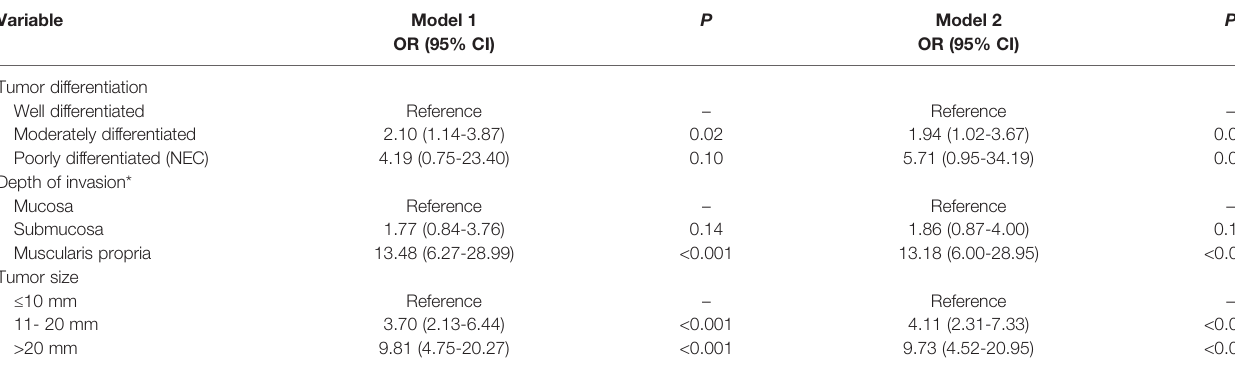
TABLE 4 | Logistic regression of factors associated with LNM in patients with d-NENs.